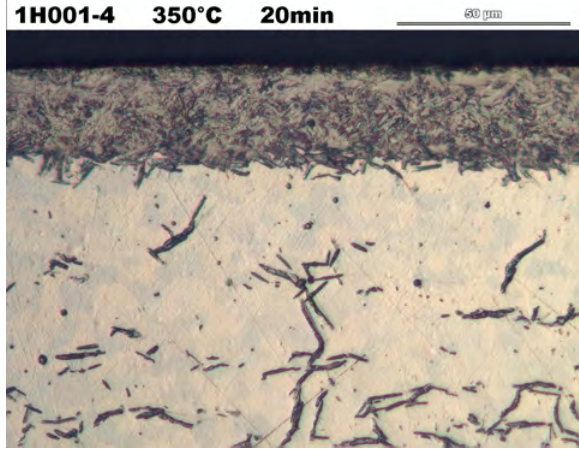
Figure 8. Sample 1H001, section 4. After hydrogen charging was used annealing at temperature 350 ◦ C and 20 minutes of time duration.